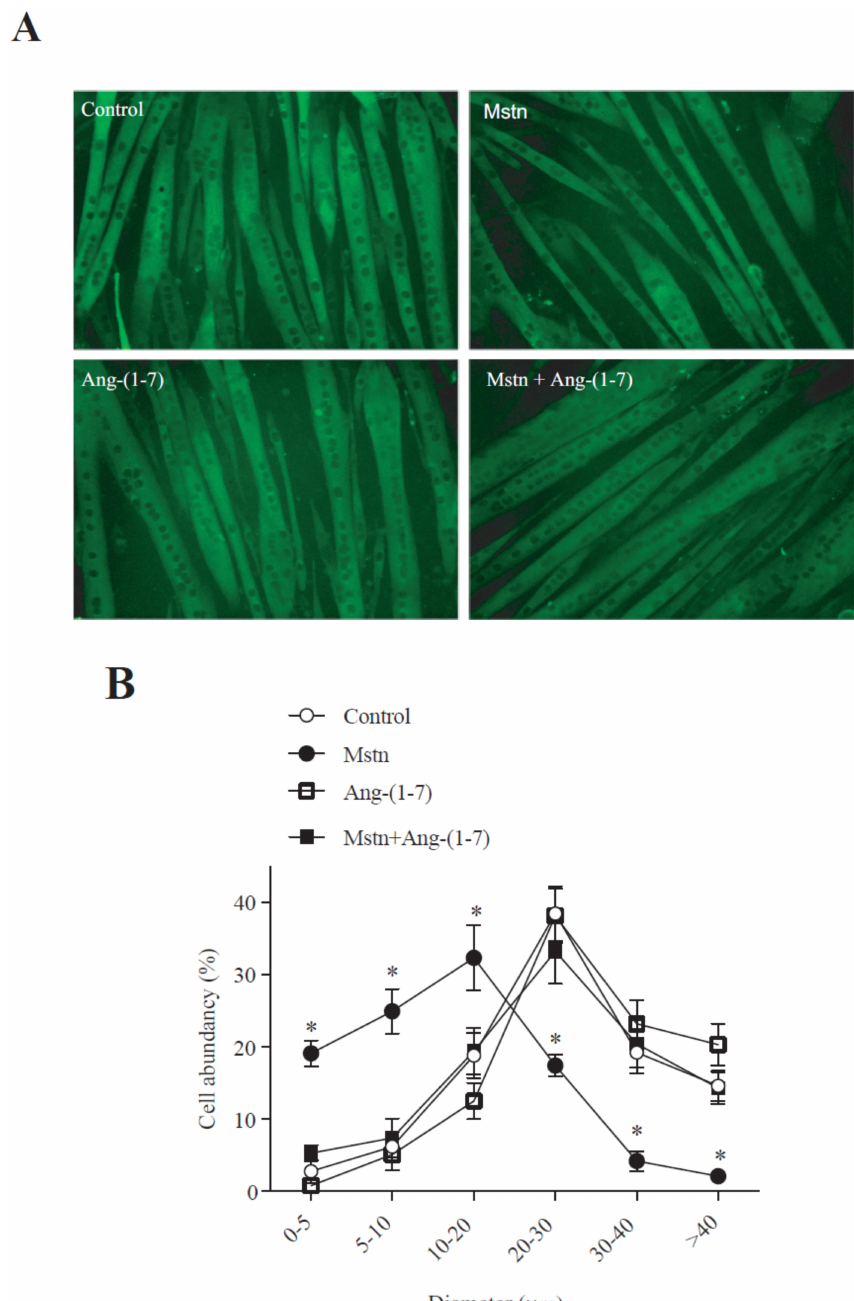
Figure 1. Angiotensin (1-7) (Ang-(1-7)) prevented the myostatin-induced decrease of the myotube diameter. ( A ) C 2 C 12 myoblasts differentiated for five days (myotubes) were pre-incubated in the absence or presence of Ang-(1-7) (10 nM) for 60 min, and then incubated with myostatin (Mstn, 1 µ g / mL) for 72 h. Myosin heavy chain (MHC; green) was detected through indirect immunofluorescence (IFI). Hoechst was used to stain the nuclei (blue). The bar scale represents 100 µ m. ( B ) The graphics show the distribution of the myotube diameters. The values are expressed as a percentage of the total myotubes and correspond to the mean ± standard deviation (SD) from three independent experiments ( n = 3; * p < 0.05 vs. control). Then, we evaluated the e ff ect of Ang-(1-7) on the decrease of the sarcomeric protein levels induced by myostatin. Figure 2A shows the protein levels of MHC and troponin detected by Western blot analysis. The quantification of the densitometric analysis of the experiments shown in Figure